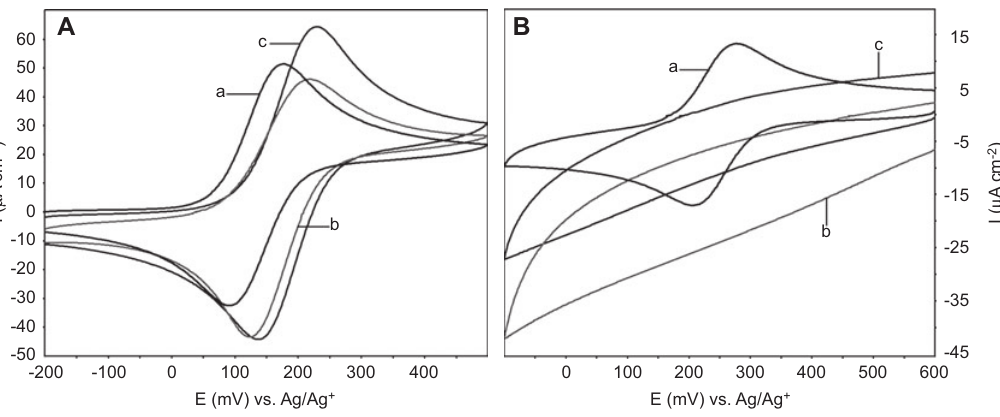
Figure 3 Cyclic voltammograms of the bare GC and PolyChr/GC (A) 1 m m ferrocene redox probe solution vs. Ag/Ag + (10 m m ) in MeCN + 0.1 M TBATFB, (a) bare GC electrode and PolyChr/GC electrode, (b) in aqueous media, (c) in non-aqueous medium. (B) 1 m m Fe(CN) probe solution vs. Ag/AgCl/(3 m KCl) in BR buffer solution, pH 2.0, (a) bare GC and PolyChr/GC, (b) in aqueous medium, (c) in non-aqueous medium. Sweep rate is 100 mV s -1